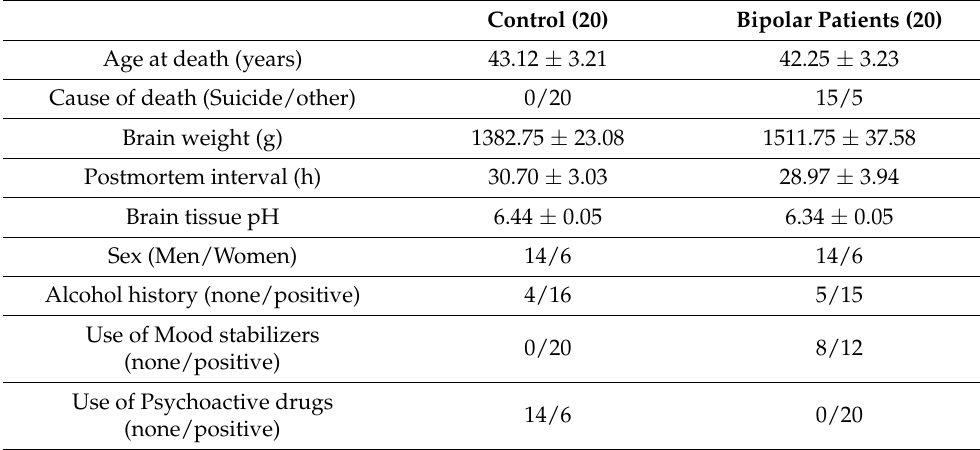
Table 3. Characteristics of BD patients and unaffected